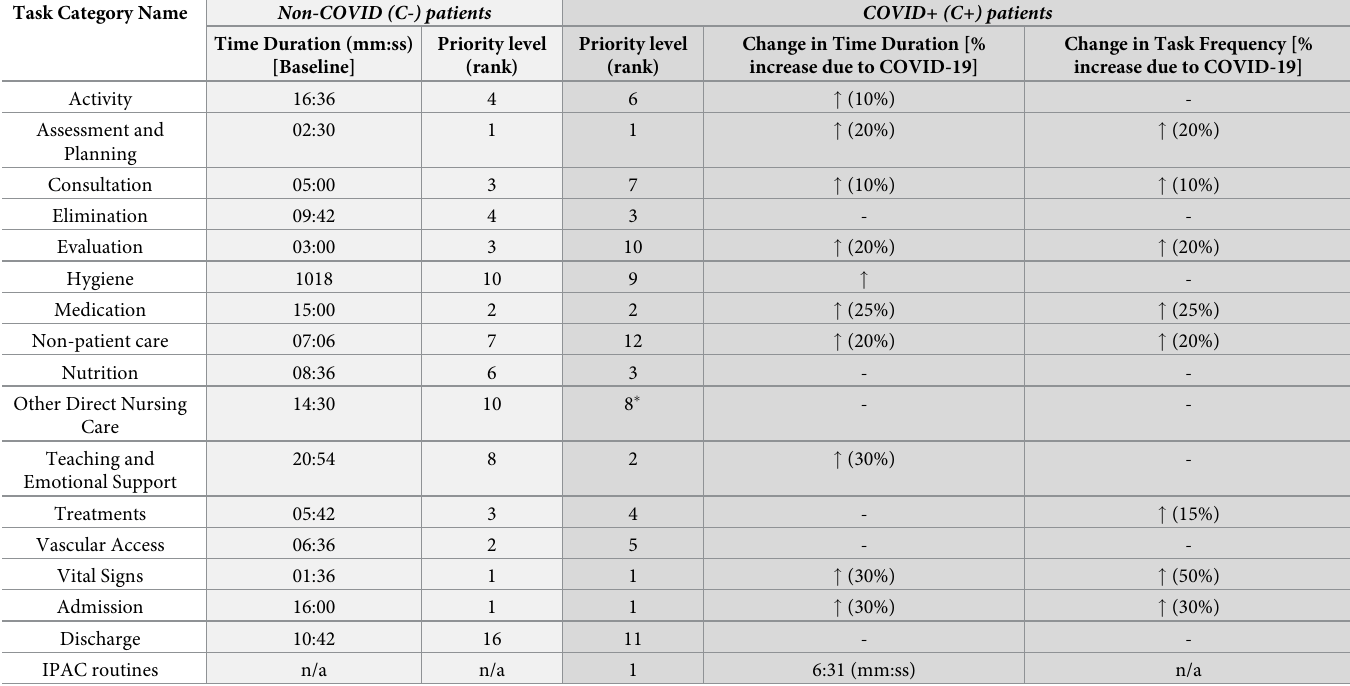
Table 1. Summary of the care task groups programmed into the DES model and their task duration, priority rank, and sensitivity to COVID-19 where C+ = COVID+ patients; C- = non-COVID patients. IPAC routines were necessitated by the pandemic and are specific for C+ patients only. Task Category